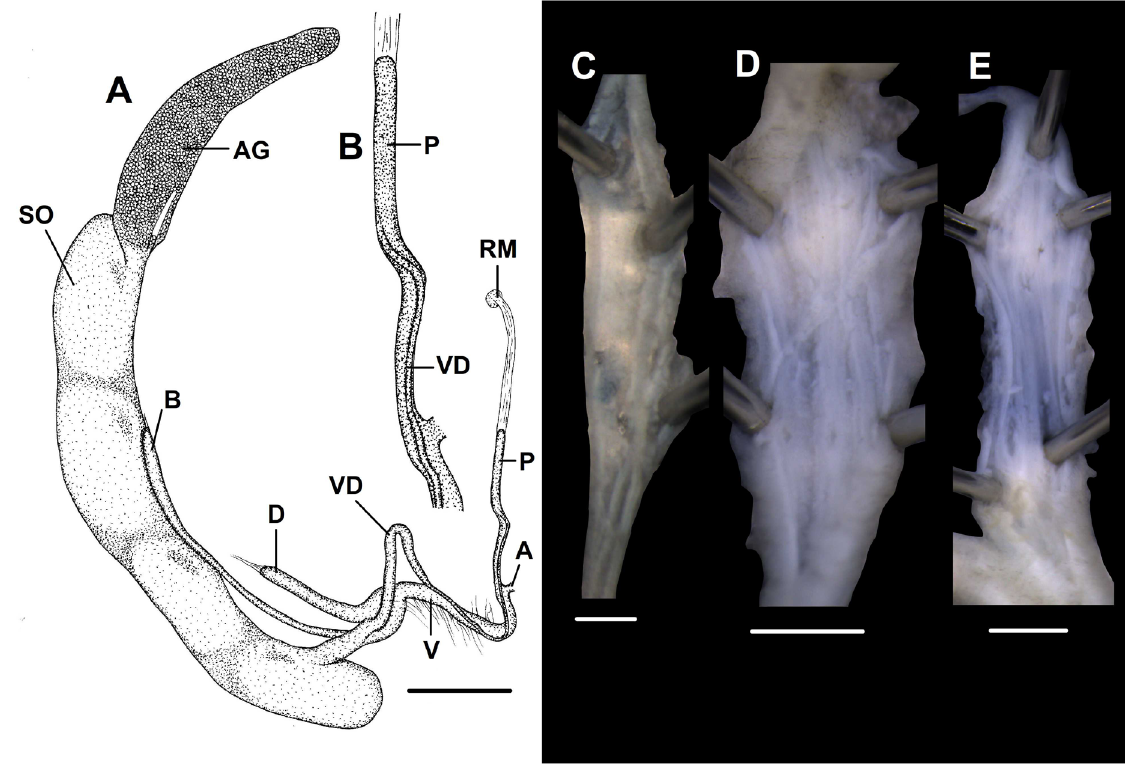
Fig. 25. Genitalia of Chersaecia perrierae (Gude, 1898) (NHMUK 20170148). A . Whole genitalia. B . Male genitalia (penis and vas deferens). C–E . Inner structure of genital organs (C = penis, D = vagina, E = diverticulum). Scale bars: A = 2 mm; C–E = 0.5 mm; B not to scale. For abbreviations see Fig. 2. All photos: B.